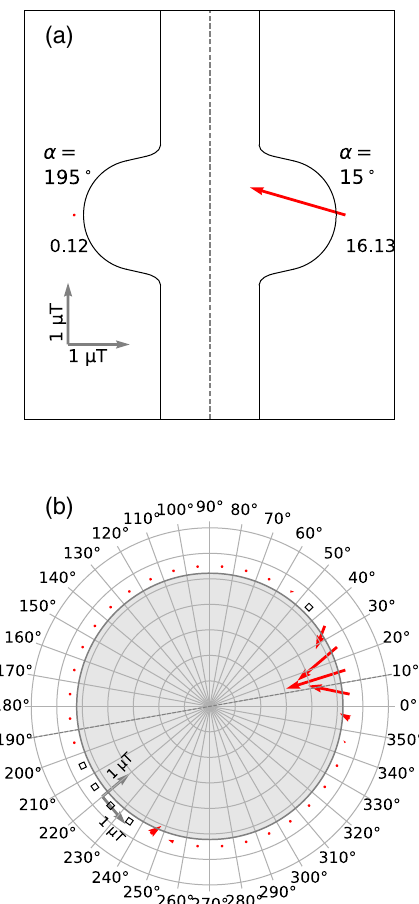
FIG. 11. Example of a 2D image of the change in the magnetic field between, before, and after quenching with a − 18 μ T magnetic field. (a) shows the z - θ projection and (b) shows the z - θ projection. In the plot (a), the numbers next to the arrows show the absolute value ( μ T) of magnetic field